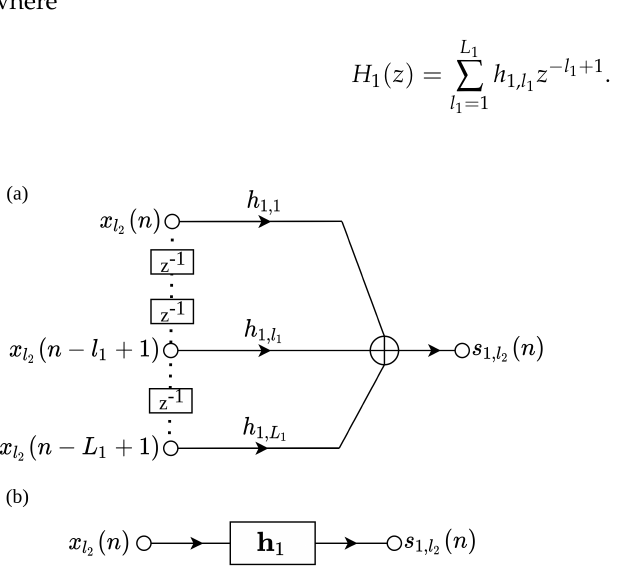
( n ) with delay line and ( b ) its symbolic representation. 2